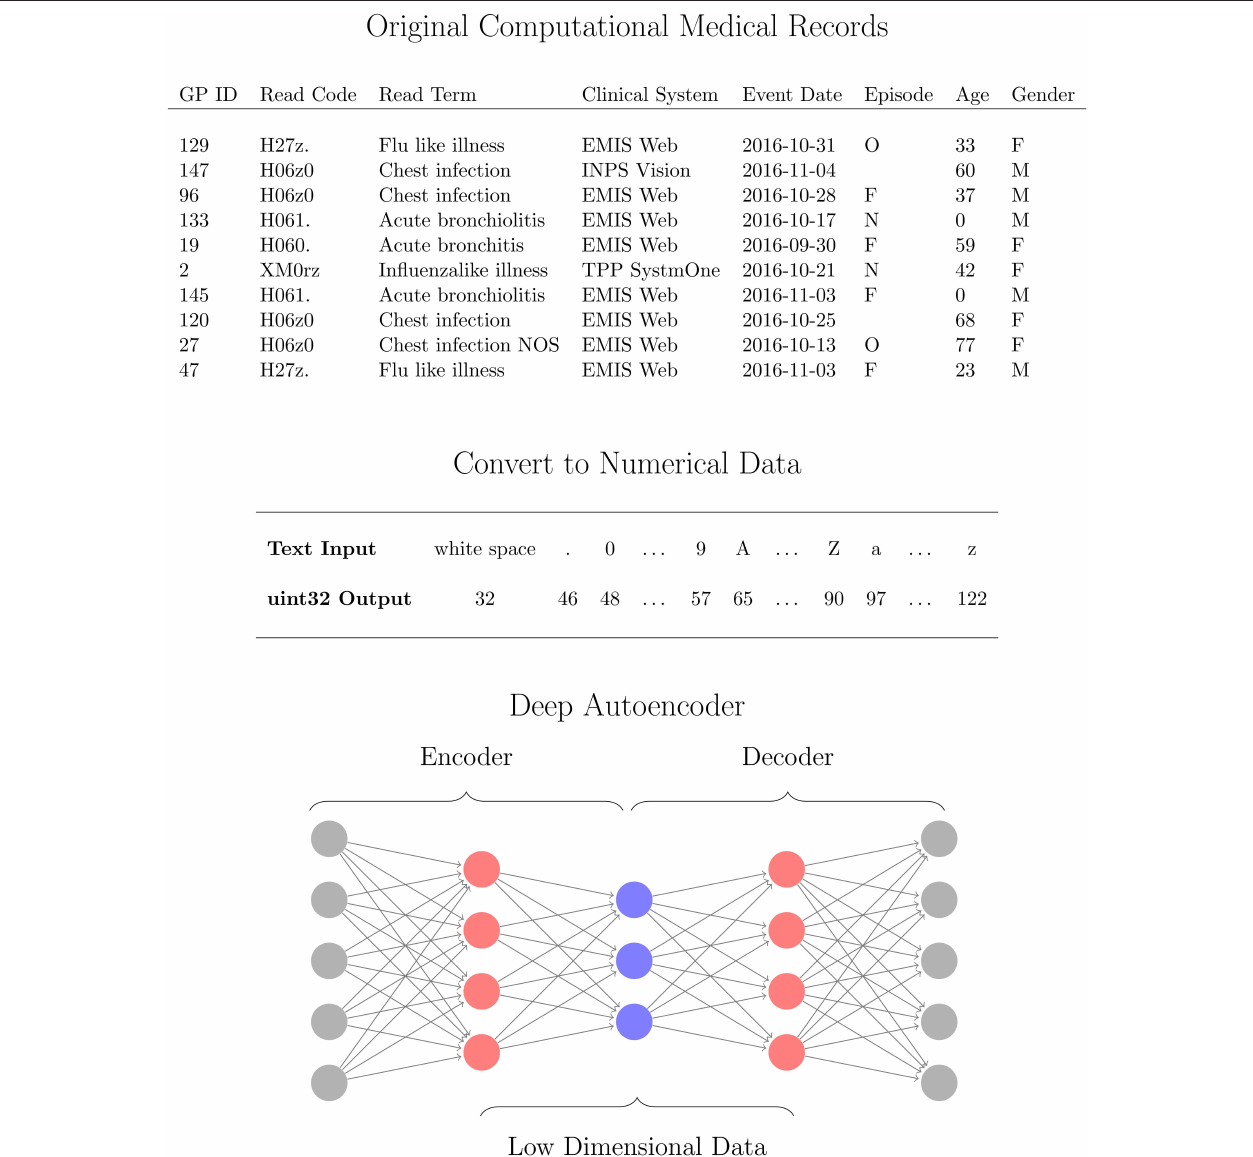
FIGURE 1 | Workflow for analysing computational medical records (CMR) with a deep autoencoder (DAE). The high dimensional CMR data (Top) is converted to Numerical data (Middle) for all attributes using 32uint conversion (MATLAB, 2016a) which are then used as inputs for the DAE (Bottom) . The DAE is trained to learn a low dimensional representation (blue neurons) of the converted CMR data (gray neurons) via several hidden layers (red neurons) in an unsupervised manner.